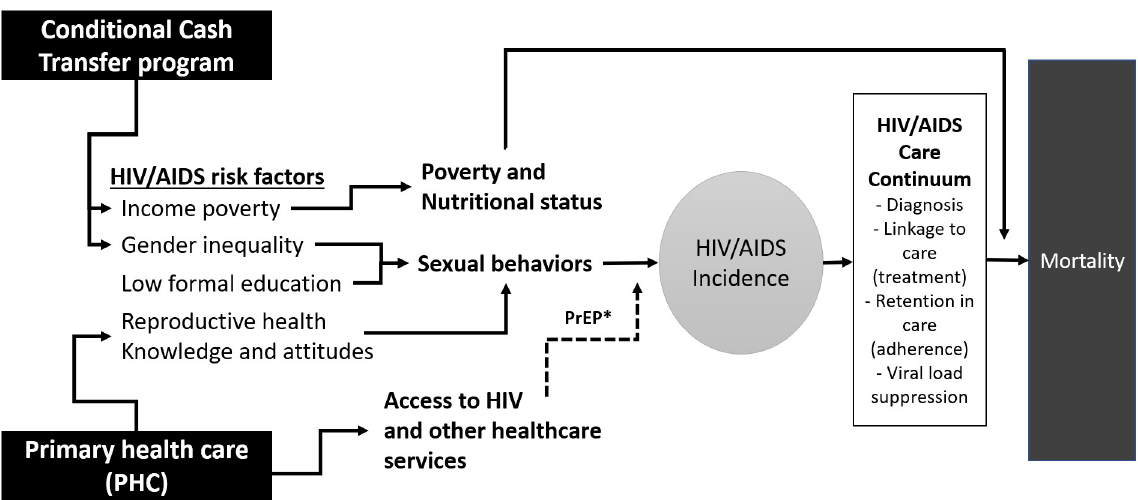
Fig 1. Conceptual framework of selected structural determinants of HIV/AIDS incidence and mortality, and of the hypothesized effects of cash transfer and PHC on this process. � Note: Pre-Exposure Prophalaxis (PrEP) is not yet widespread in Brazil and cannot yet be assessed in this